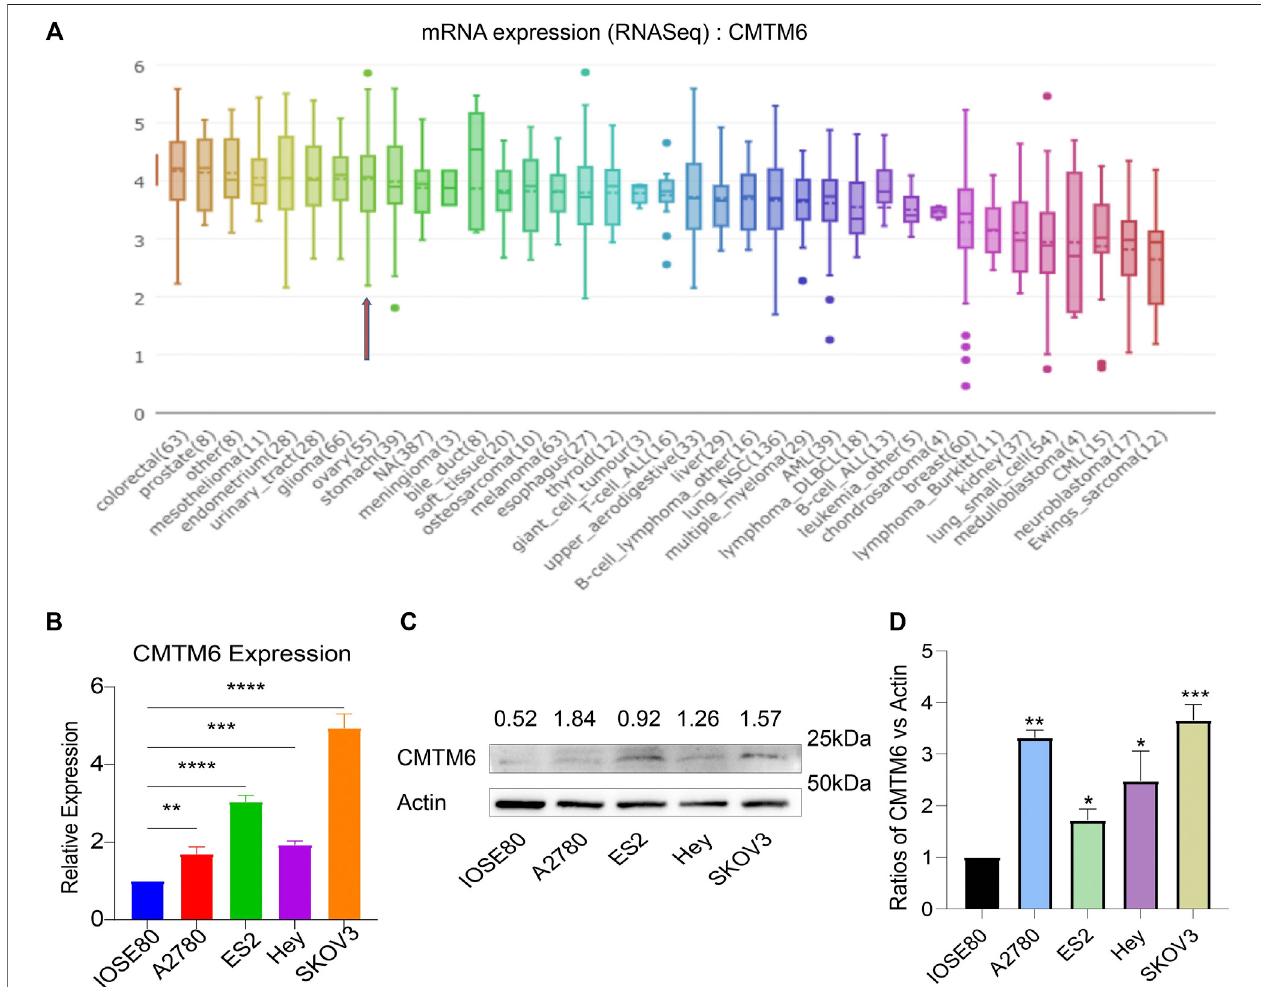
FIGURE 2 | CMTM6 expression in OV cell lines. (A) Cell line indicated by the red arrow is ovarian cancer. CMTM6 was overexpressed in OV cell lines. (B) CMTM6 mRNA expression in human OV cell lines. (C,D) CMTM6 protein expression in human cell lines. Densitometric quanti fi cation was shown. Actin served as the loading control. * p < 0.05, ** p < 0.01, *** p < 0.001, and **** p <